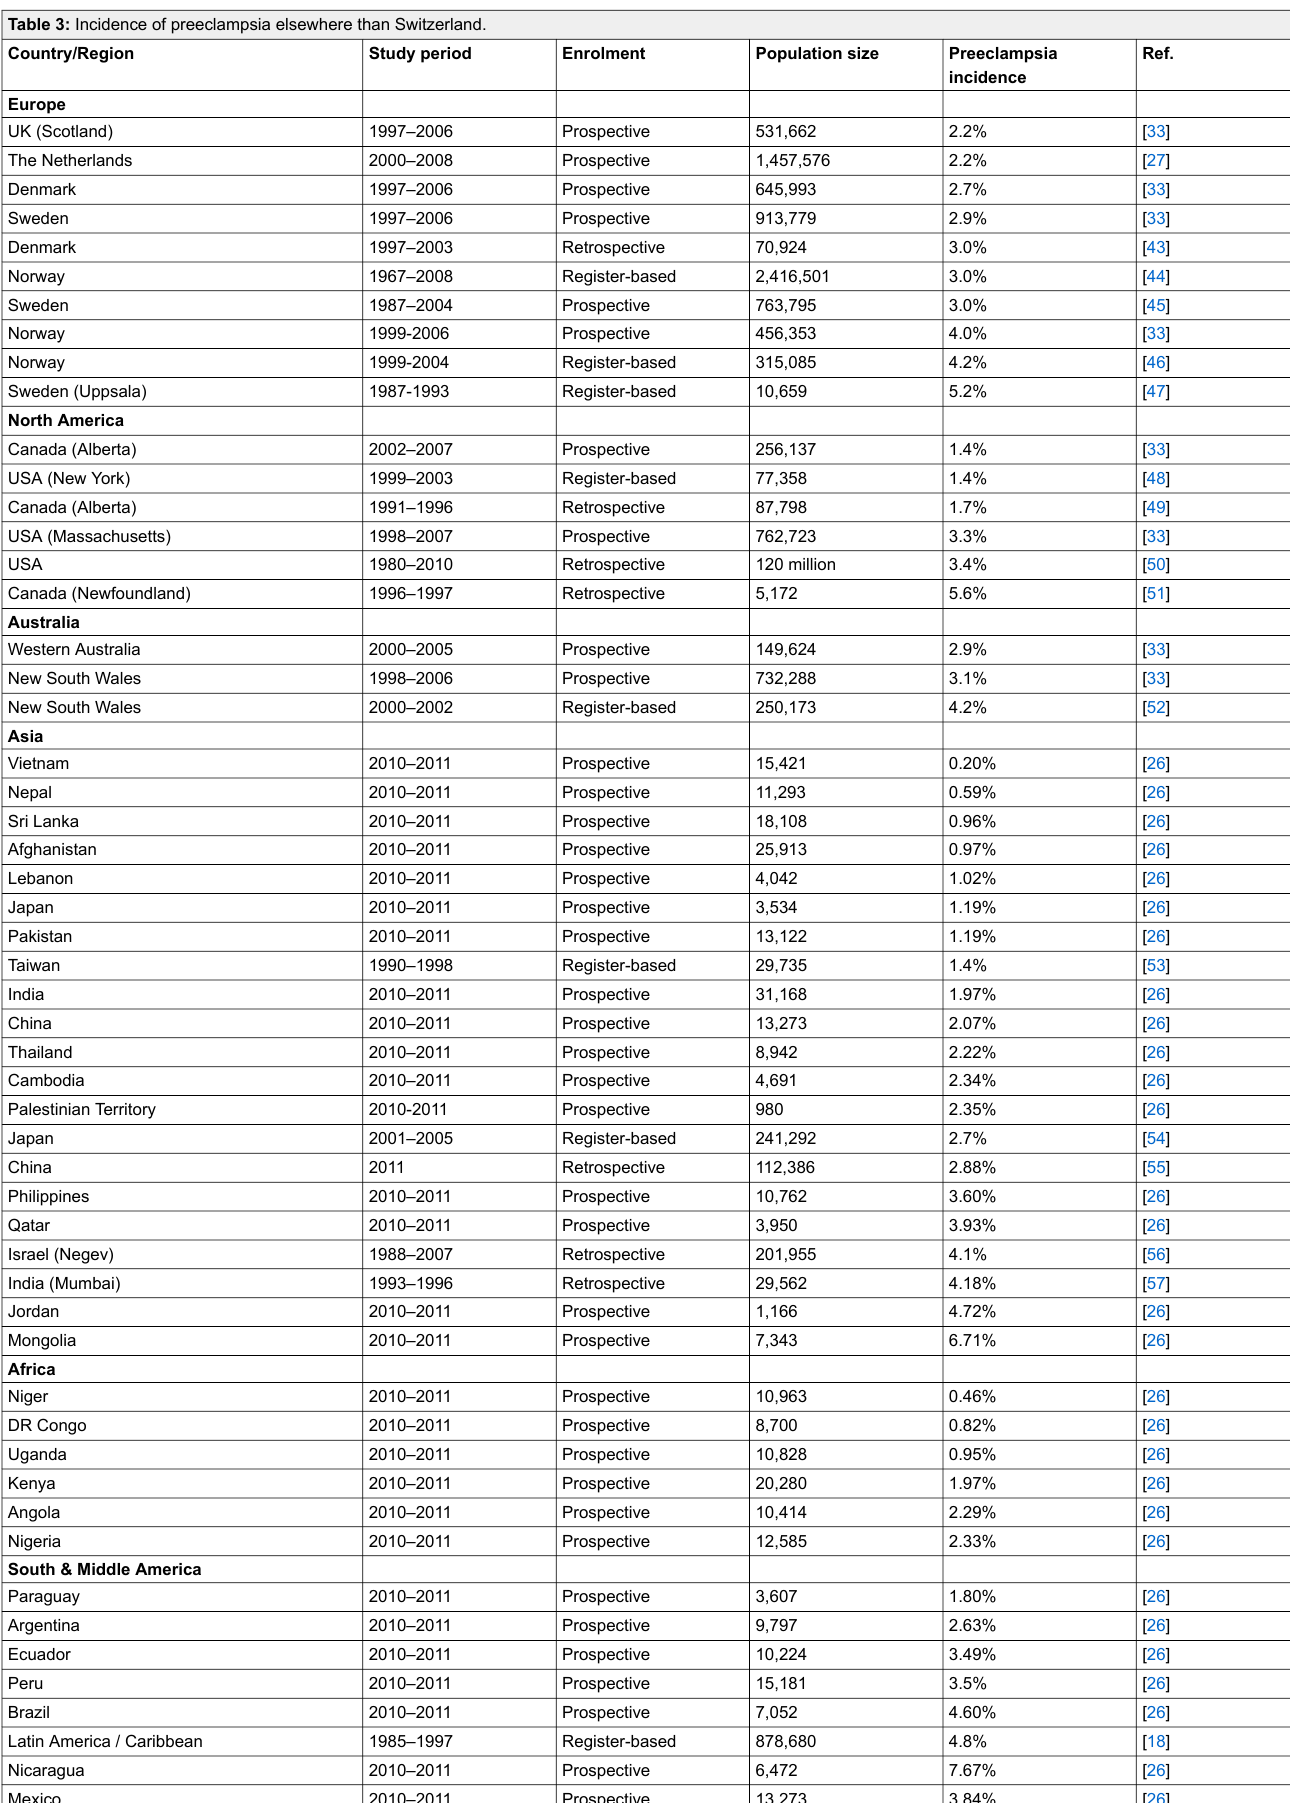
Table 3: Incidence of preeclampsia elsewhere than Switzerland.